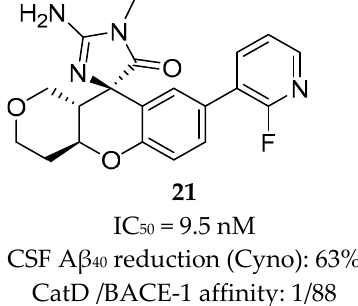
Figure 19 . Chromane-based spirocyclic acyl guanidine-derived BACE-1 inhibitor 21 develop by Array BioPharma together with Genentech [67].